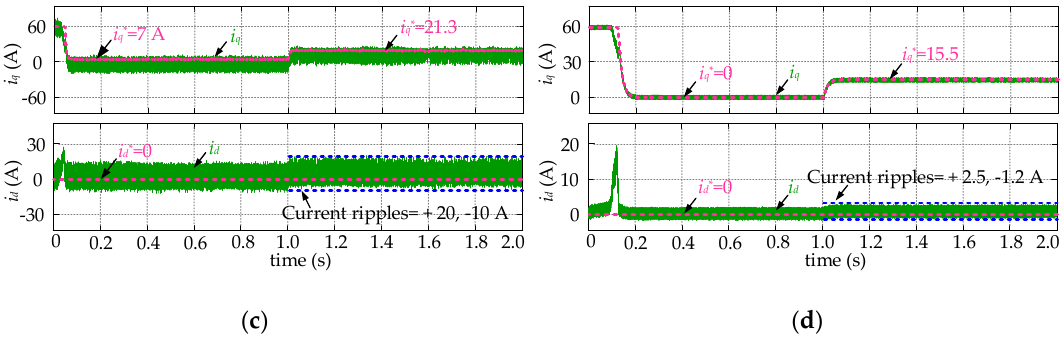
Figure 2. Current control performance versus different measured inductance values: ( a ) L 0 = L , ∆ L = 0; ( b ) L 0 = 2 L , ∆ L = − L ; ( c ) L 0 = 5 L , ∆ L = − 4 L ; ( d ) L 0 = 0.5 L , ∆ L = 0.5 L .